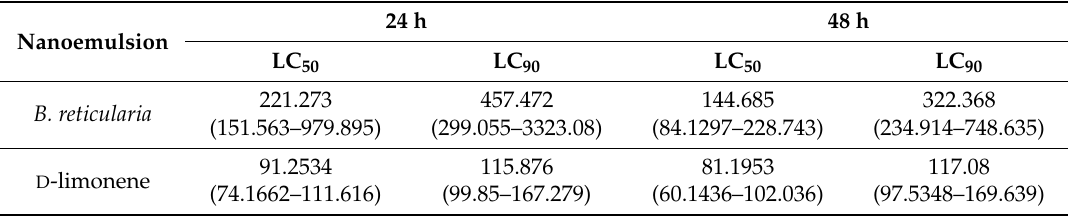
Table 4. Larvicidal activity of nanoemulsions of B. reticularia essential oil and D -limonene.